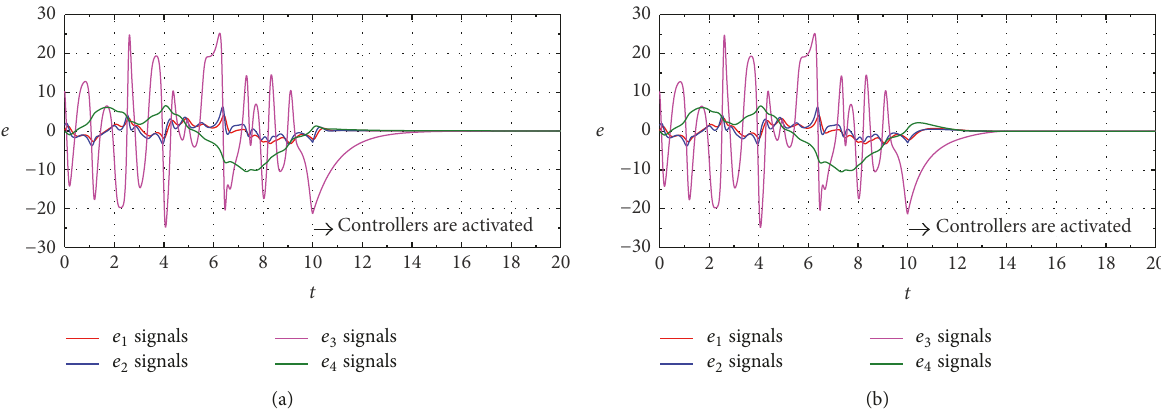
Figure 5: Synchronization errors between driver and response four-dimensional self-exciting homopolar disc dynamo hyperchaotic systems with the controllers are activated at 𝑡 = 10 : (a) active controllers and (b) sliding mode controllers.